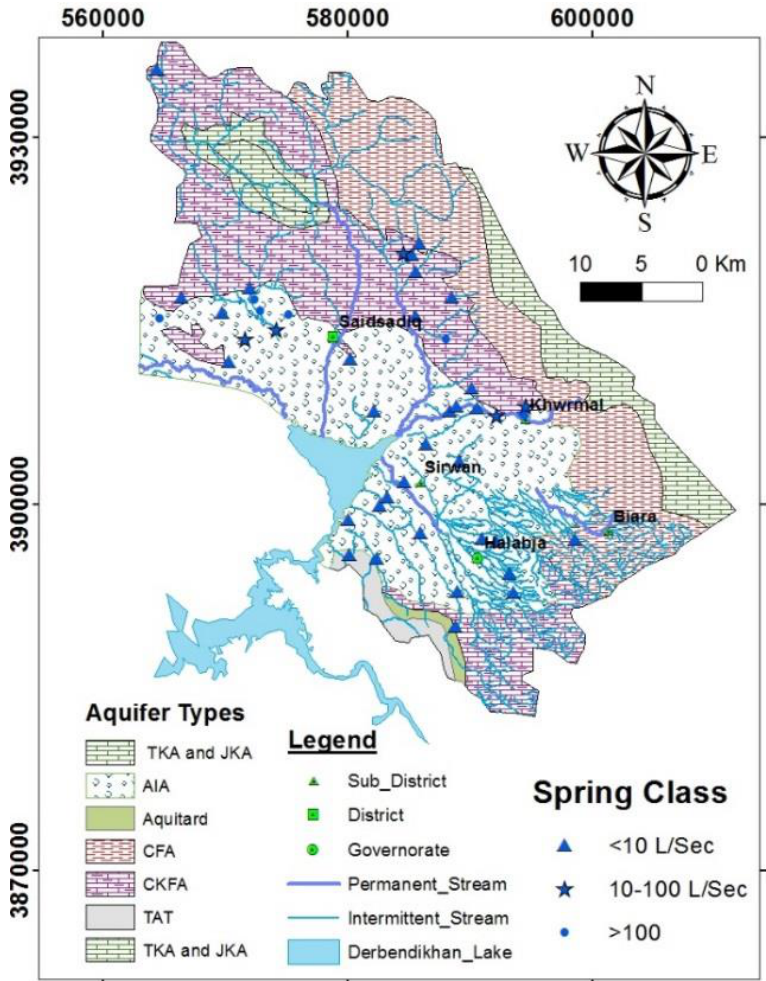
Figure 3. Hydrogeological map of the HSB, modified from [2–15].